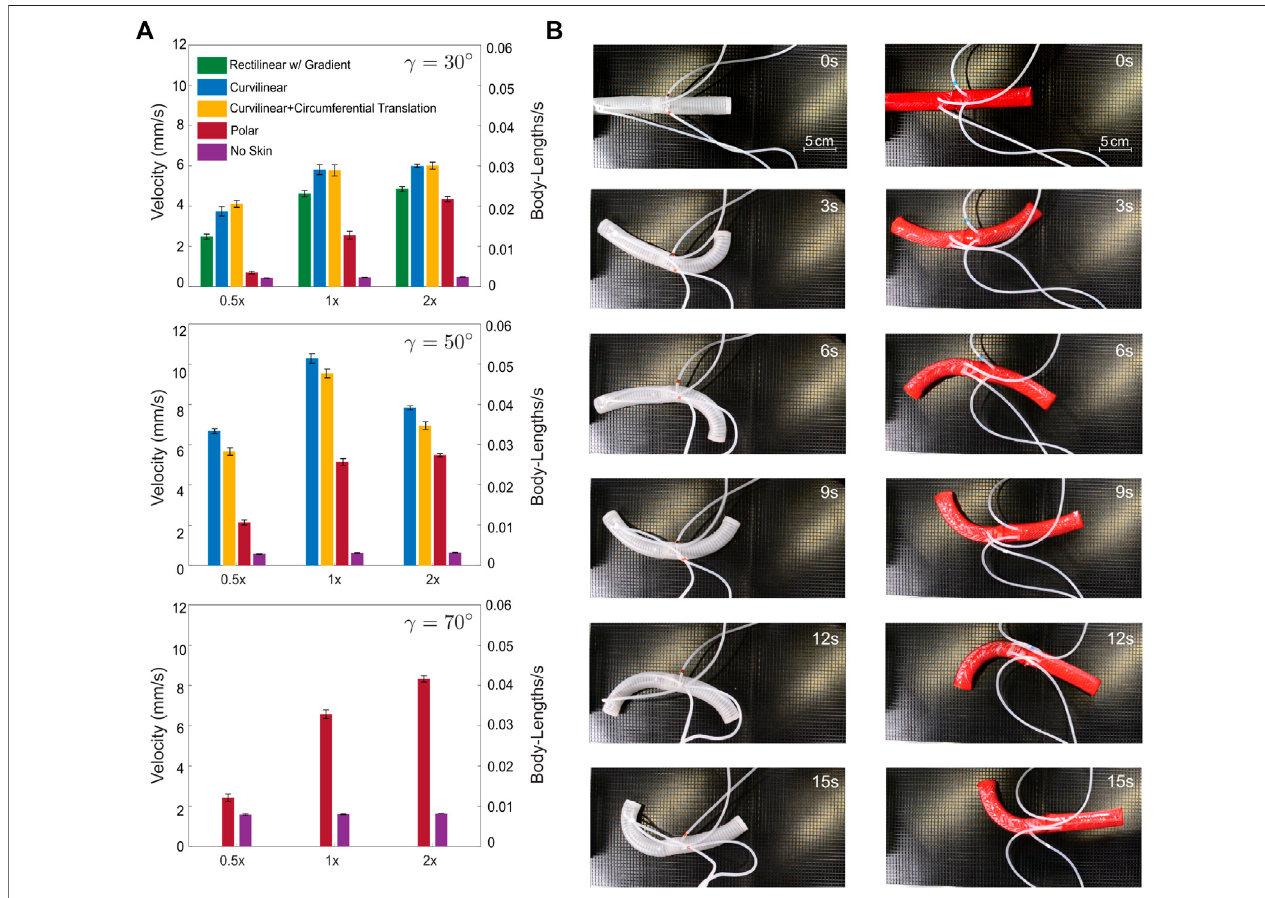
FIGURE 5 | (A) Average velocities of skins on varying surfaces. (B) Timelapse of soft snake robot without skin and with curvilinear skin on the 1x surface.